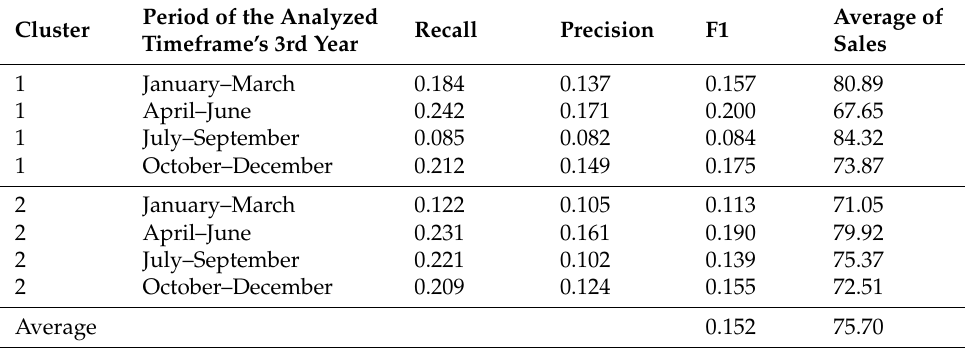
Table 9. Implementation outputs of the proposed recommendation system.